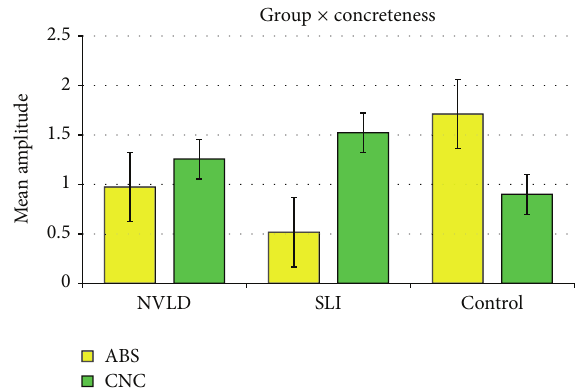
Figure4:MeanamplitudesofERPselicitedbyconcreteandabstract stimuli in the three groups. Error bars represent standard errors.